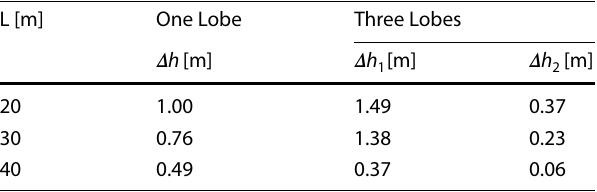
the best optimal results have been